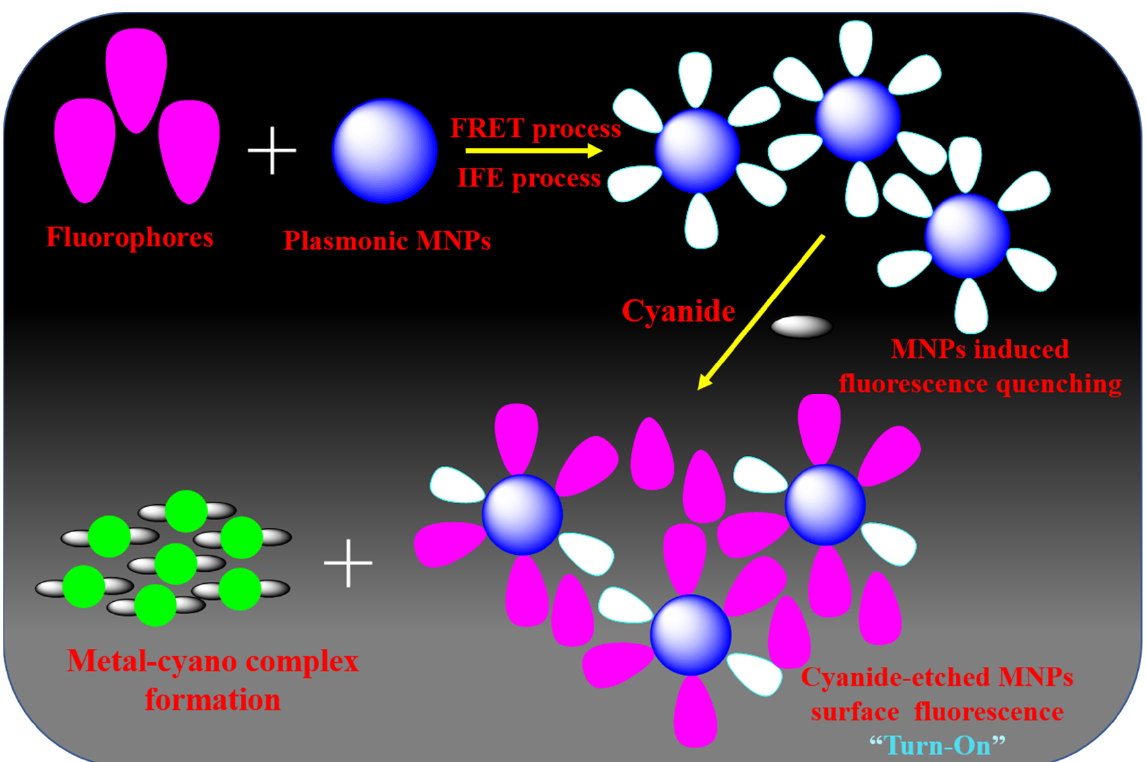
Figure 7. Possible mechanistic pathway for the detection of cyanide anion by fluorophore func- tionalized plasmonic MNPs.